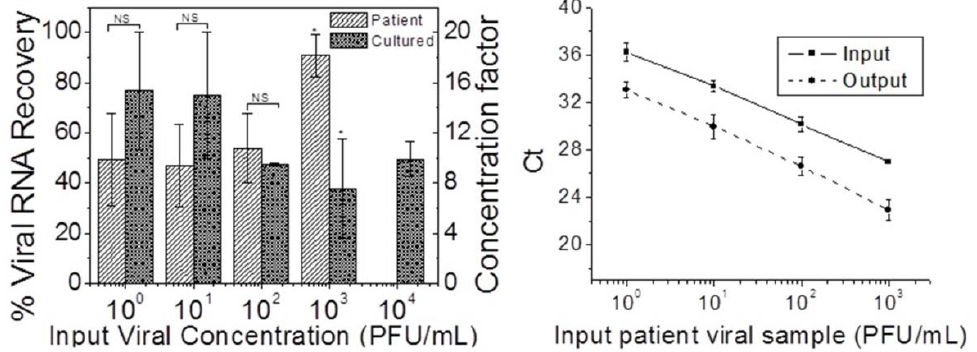
Figure 5. Left : Viral RNA recovery and concentration factor for serial dilutions of both patient and cultured influenza samples. Both input and output samples from the concentrator are processed with the QIAamp Viral RNA mini kit. Cultured: n = 3. Patient: n ≥ 3 (for all except the undiluted specimen). NS: not significant; * P < 0.05; two sample before and after concentration unpaired two-tailed Student’s t -test. Right : Comparison of C T for patient nasal pharyngeal fluid viral